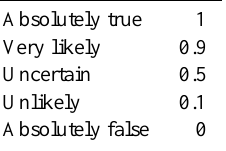
Table 1. Proposal of conversion rule of expert judgment into prob- ability for the statement “the intensity is equal to or greater than a given class”. Absolutely true 1 Very likely 0.9 Uncertain 0.5 Unlikely 0.1 Absolutely false 0